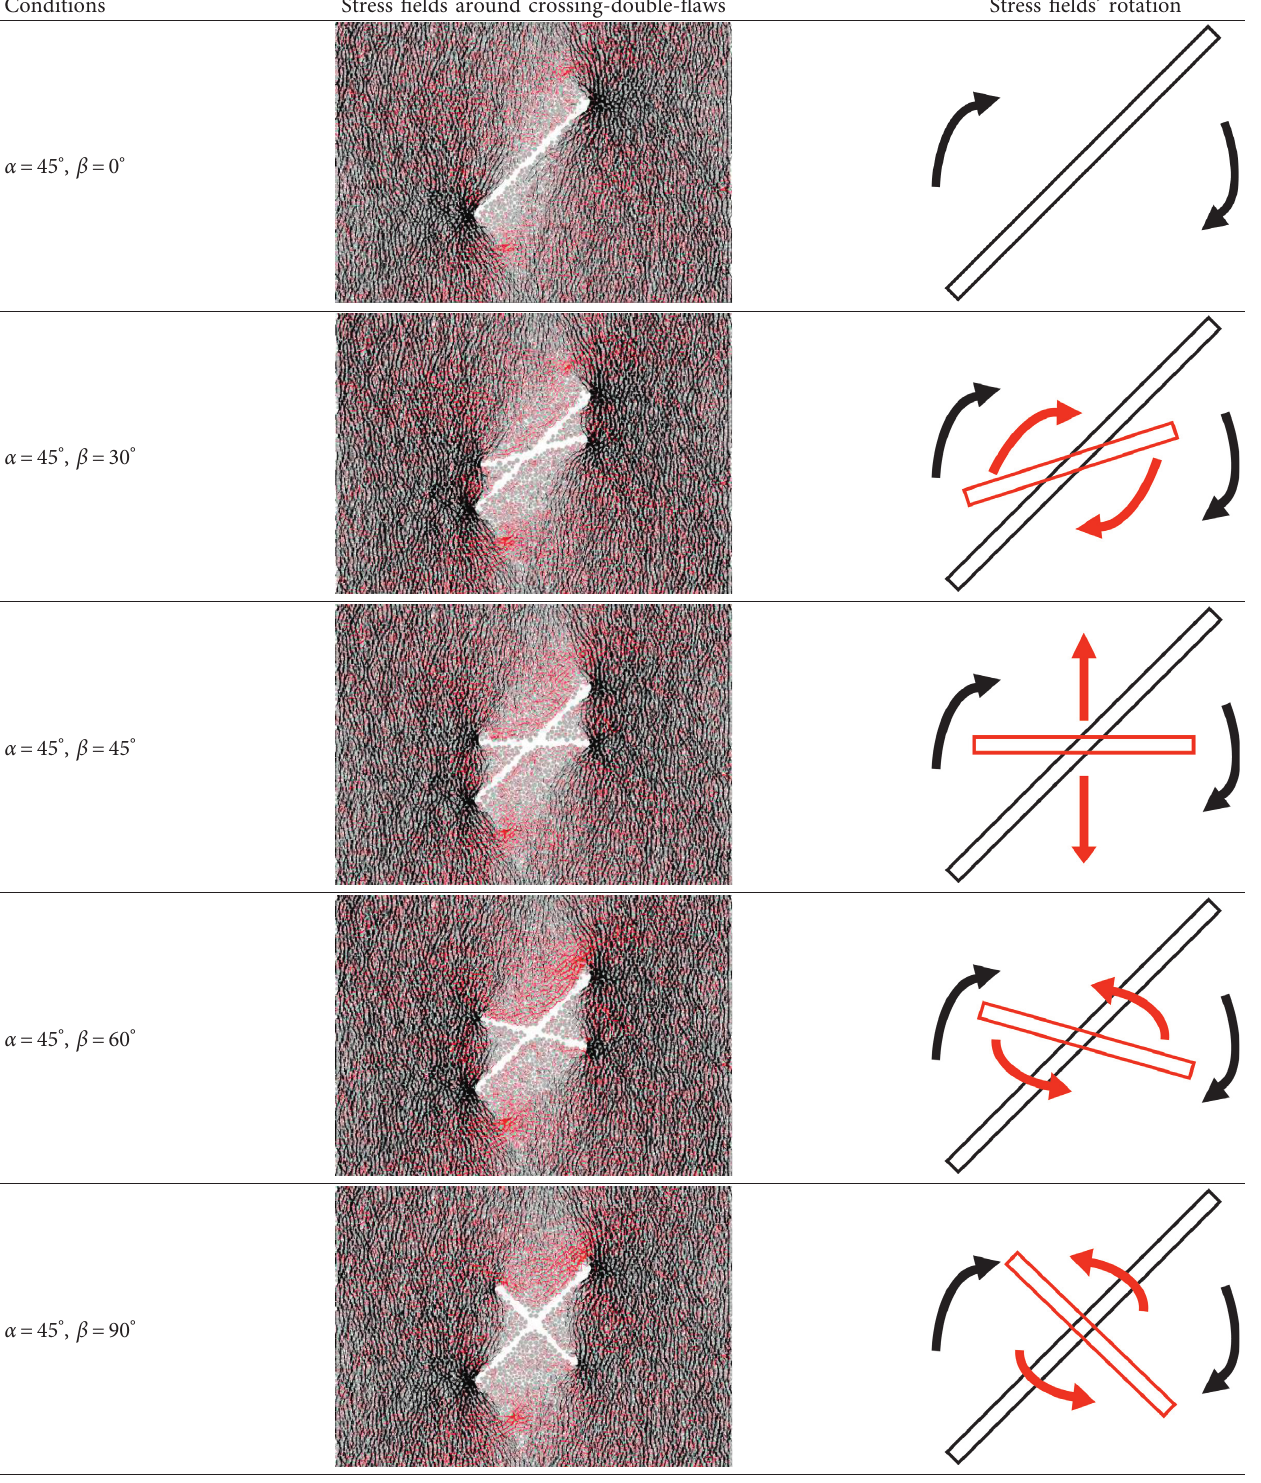
Table 5: Force concentrations around the crossing-double-flaws at α of 45 ° when the initiation of first macrocracks. Conditions Stress fields around crossing-double-flaws Stress fields’